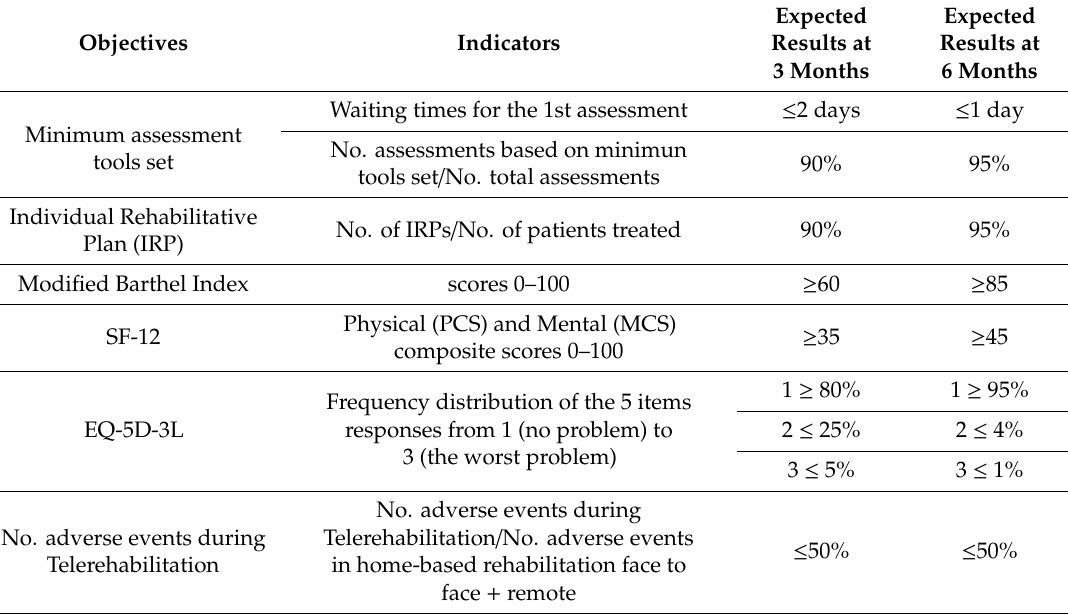
Table 2. Primary objectives, indicators, and expected